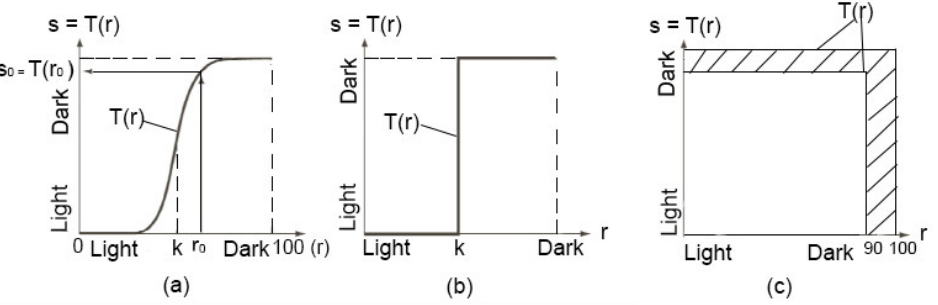
Figure 9. Level transformation functions values for grayscale images ( a ), ( b )—Our proposed shown ( c ).